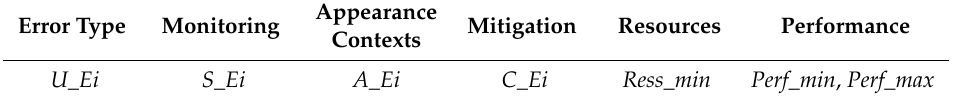
Table 3. FMEA table for the error mitigation with embedded constraints ( FMEA _ EMB pattern).